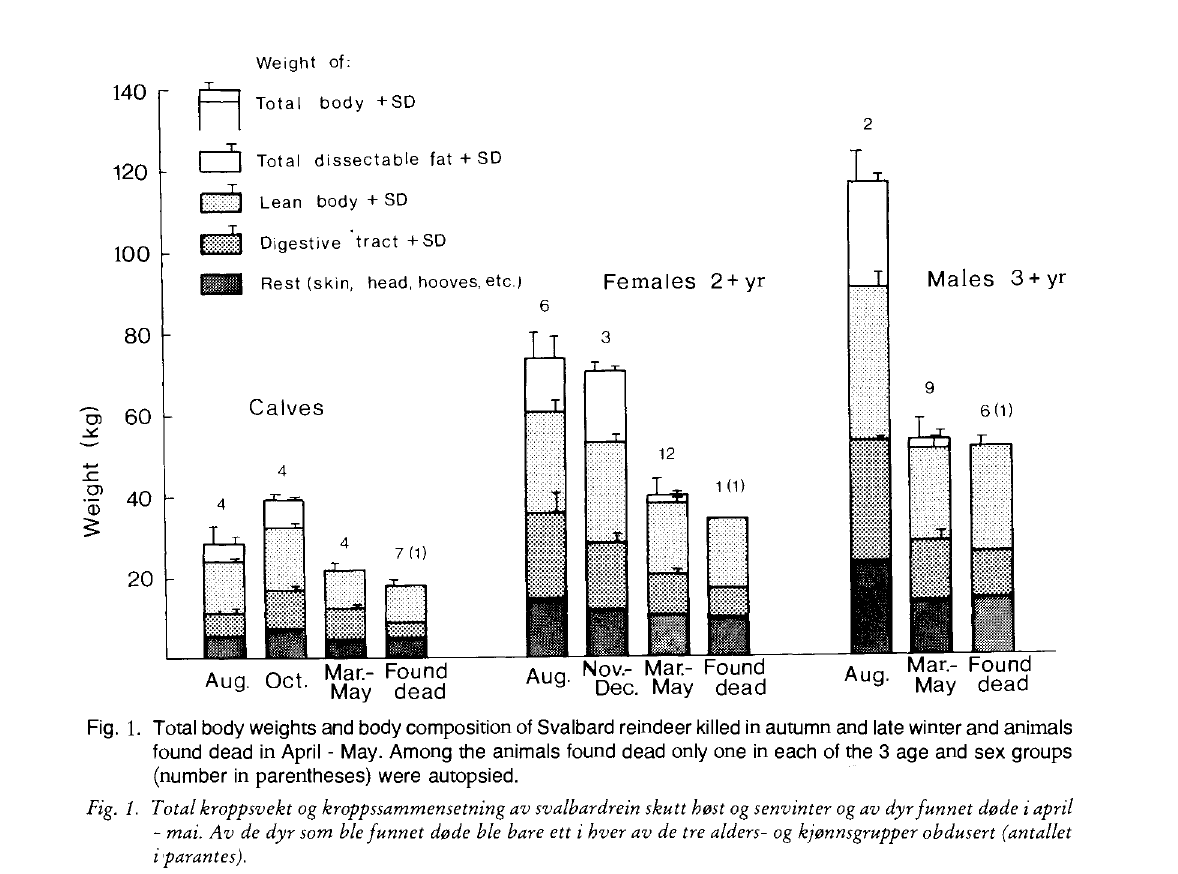
Total body weights and body composition of Svalbard reindeer killed in autumn and late winter and animals found dead in April - May. Among the animals found dead only one in each of the 3 age and sex groups (number in parentheses) were